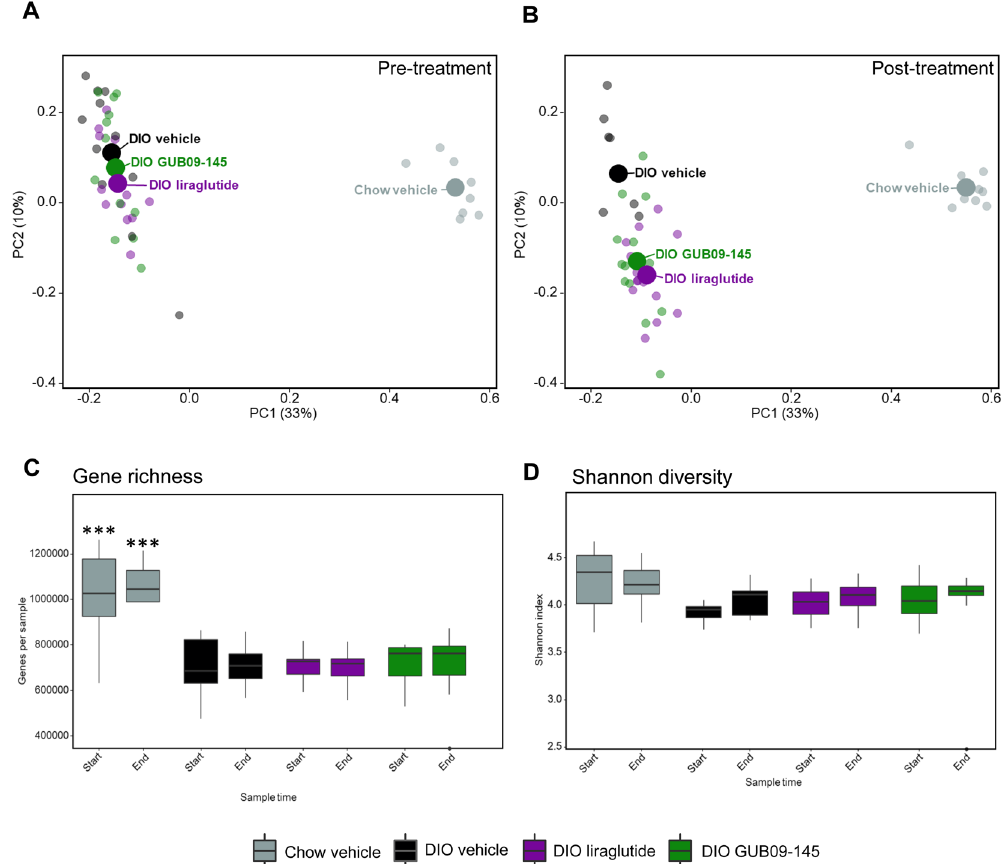
Figure 4. Shotgun metagenomics. Principal Coordinate Analysis (PCoA) based on Bray-Curtis dissimilarity between all samples calculated using species relative abundances (panels A,B). PCoA plots demonstrate pre- and post-treatment gut microbiome signatures in all individual mice, group means are indicated by a large point. Microbial diversity analysis at species level, including gene richness ( C ) and Shannon alpha diversity ( D ). *** p < 0.001 vs. corresponding sampling time in DIO vehicle